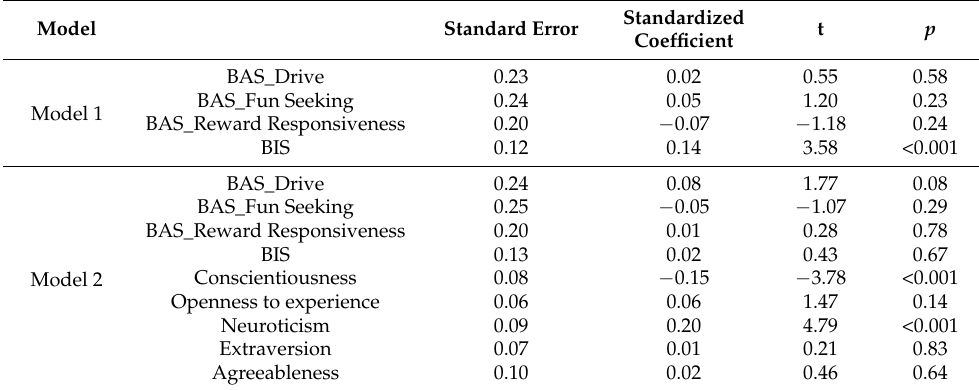
Table 2. Hierarchical linear regression on total BWAQ